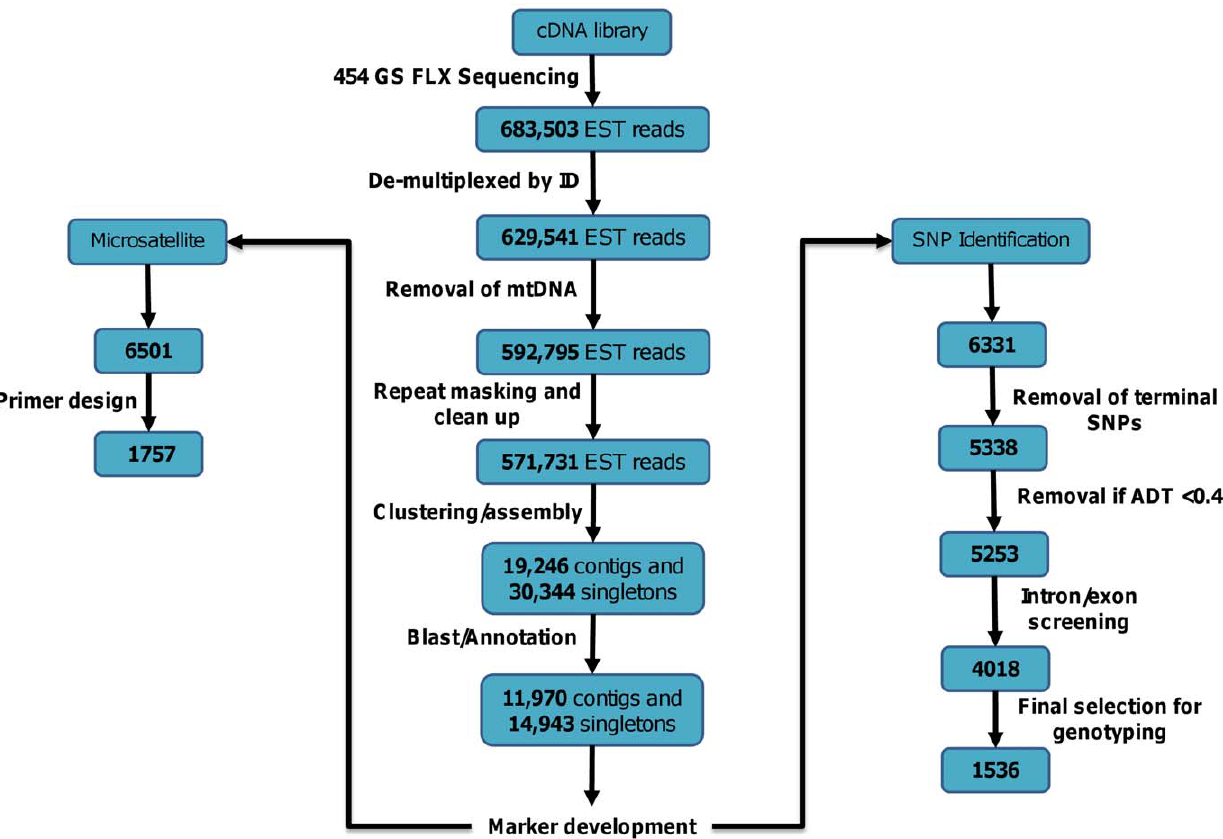
Figure 2. Schematic of transcript assembly and SNP detection pipeline. Schematic overview with numbers of reads, contigs and SNPs through the transcript assembly (centre) SNP detection (right hand side) and microsatellite detection (left hand side) pipelines (see text for more details).